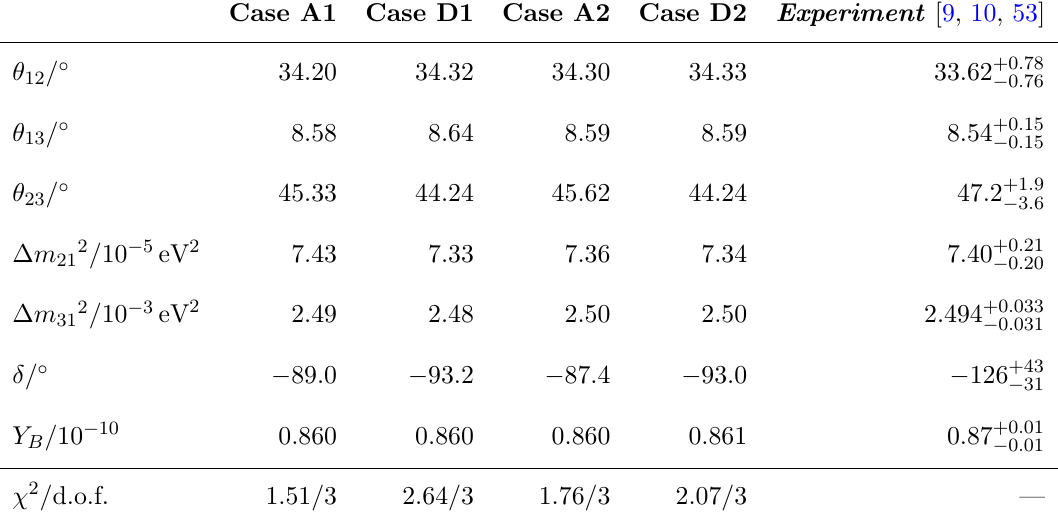
Table 3 . Benchmark Point Observables.